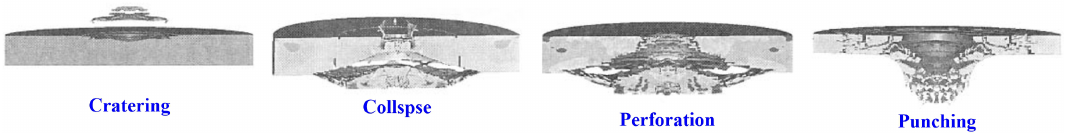
Figure 13. Typical damage mode of concrete panels caused by contact explosion